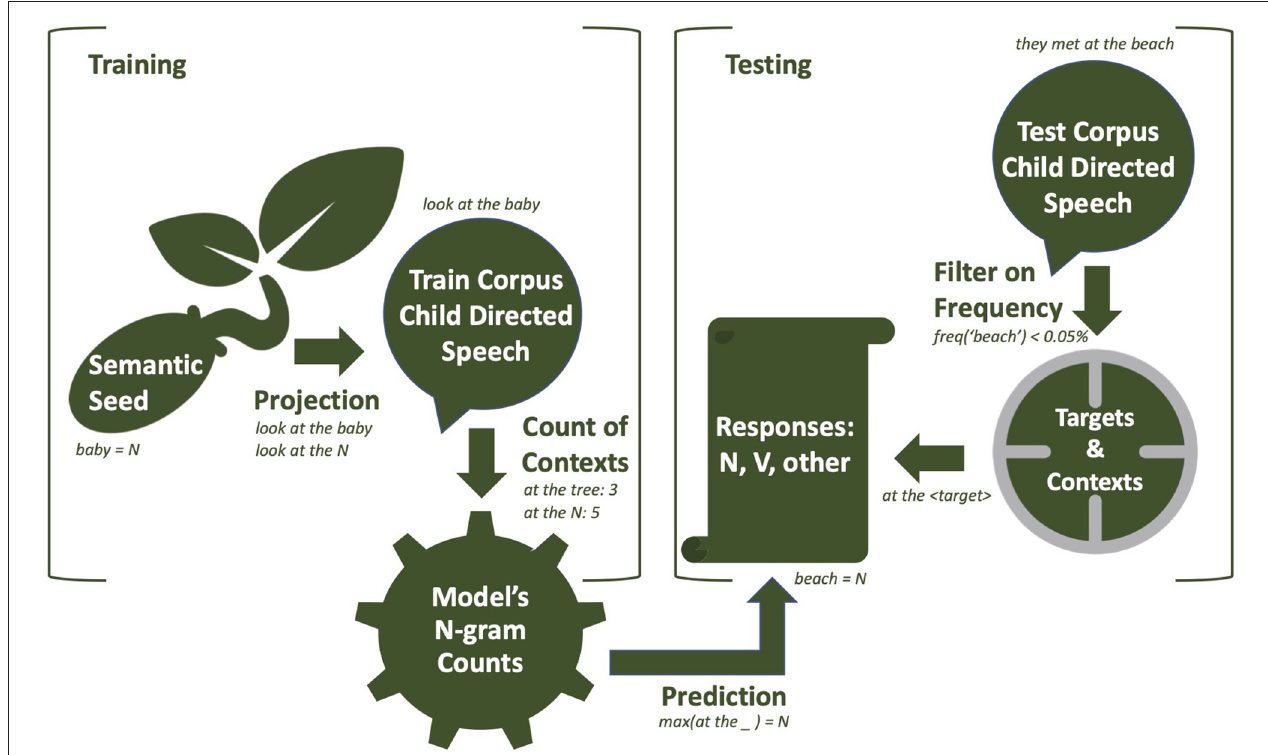
FIGURE 1 | A representation of the different steps of training and testing from our model. Details about the mechanisms can be found in the section Training and Testing.